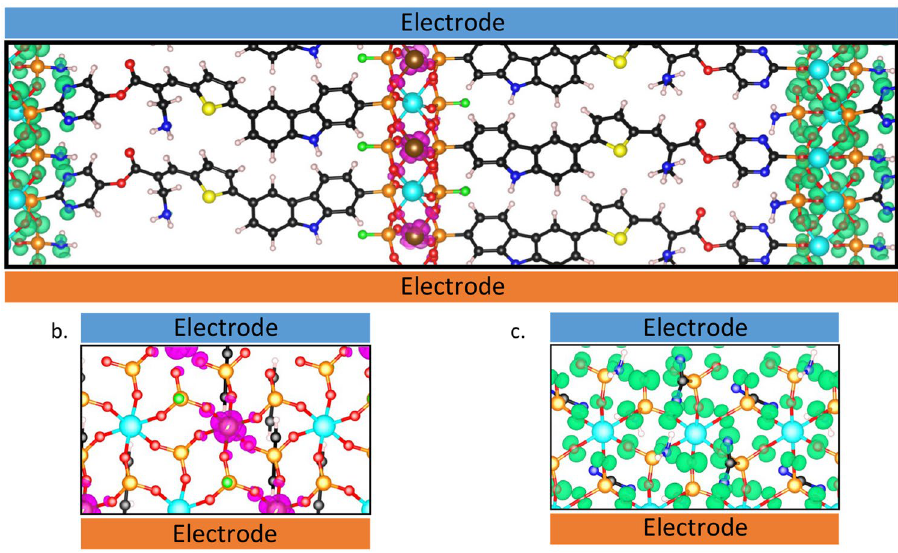
Figure 6. ( a ) The xz-plane of the bulk system showing spatial localization of the density of states at the conduction band edge (purple) and the valence band edge (green), states are highly localized outside the organic region, implying that the exciton is spatially separated in this system. ( b ) The xy -plane of the electron extracting layer and ( c ). The xy -plane of the hole extracting